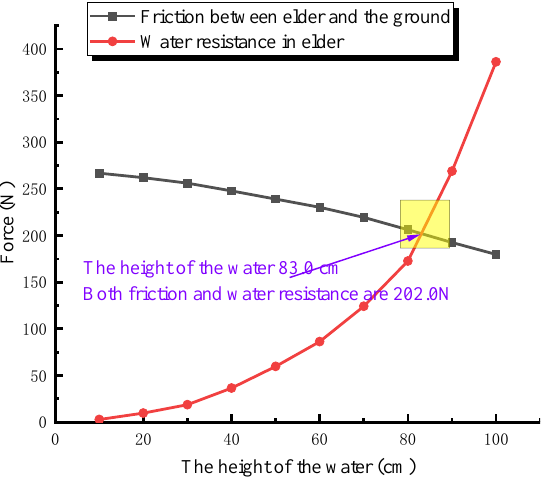
Figure 23. Curve comparison of the flood resistance and friction (child).